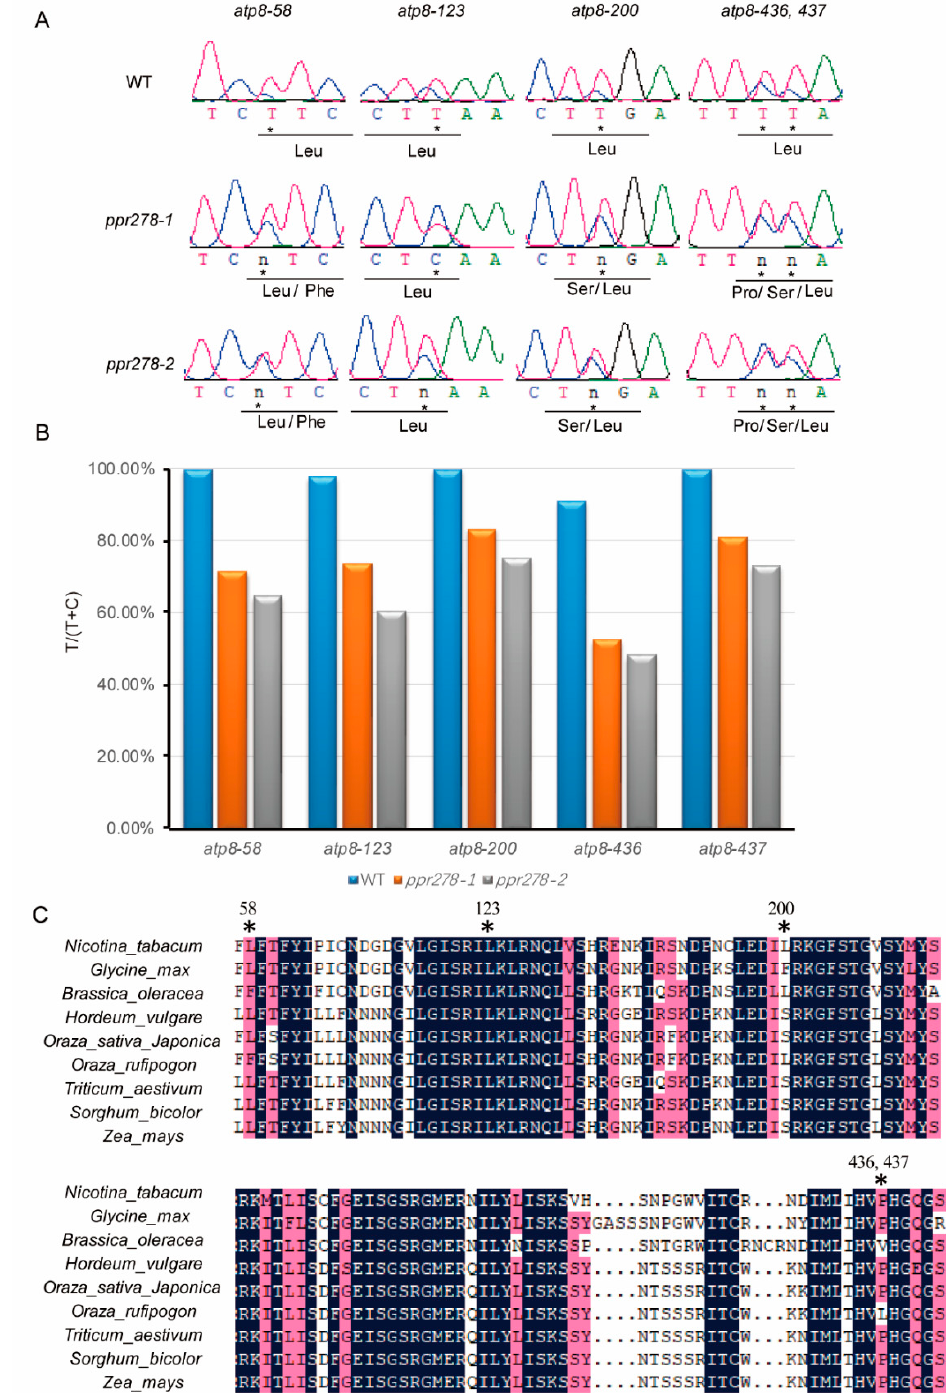
Figure 5. C-to-U RNA editing sites and efficiency in atp8 transcripts. ( A ) Editing profile of five C-to- U RNA editing sites in the atp8 transcripts in the ppr278 mutant. ( B ) C-to-U editing efficiency in atp8 transcripts; “n” stands for the peak of heterozygous genotype (C/U) in the same editing site, “*” stands for the C-to-U site in atp8 . ( C ). Comparison of amino acid sequences of atp8 in different spe- cies.